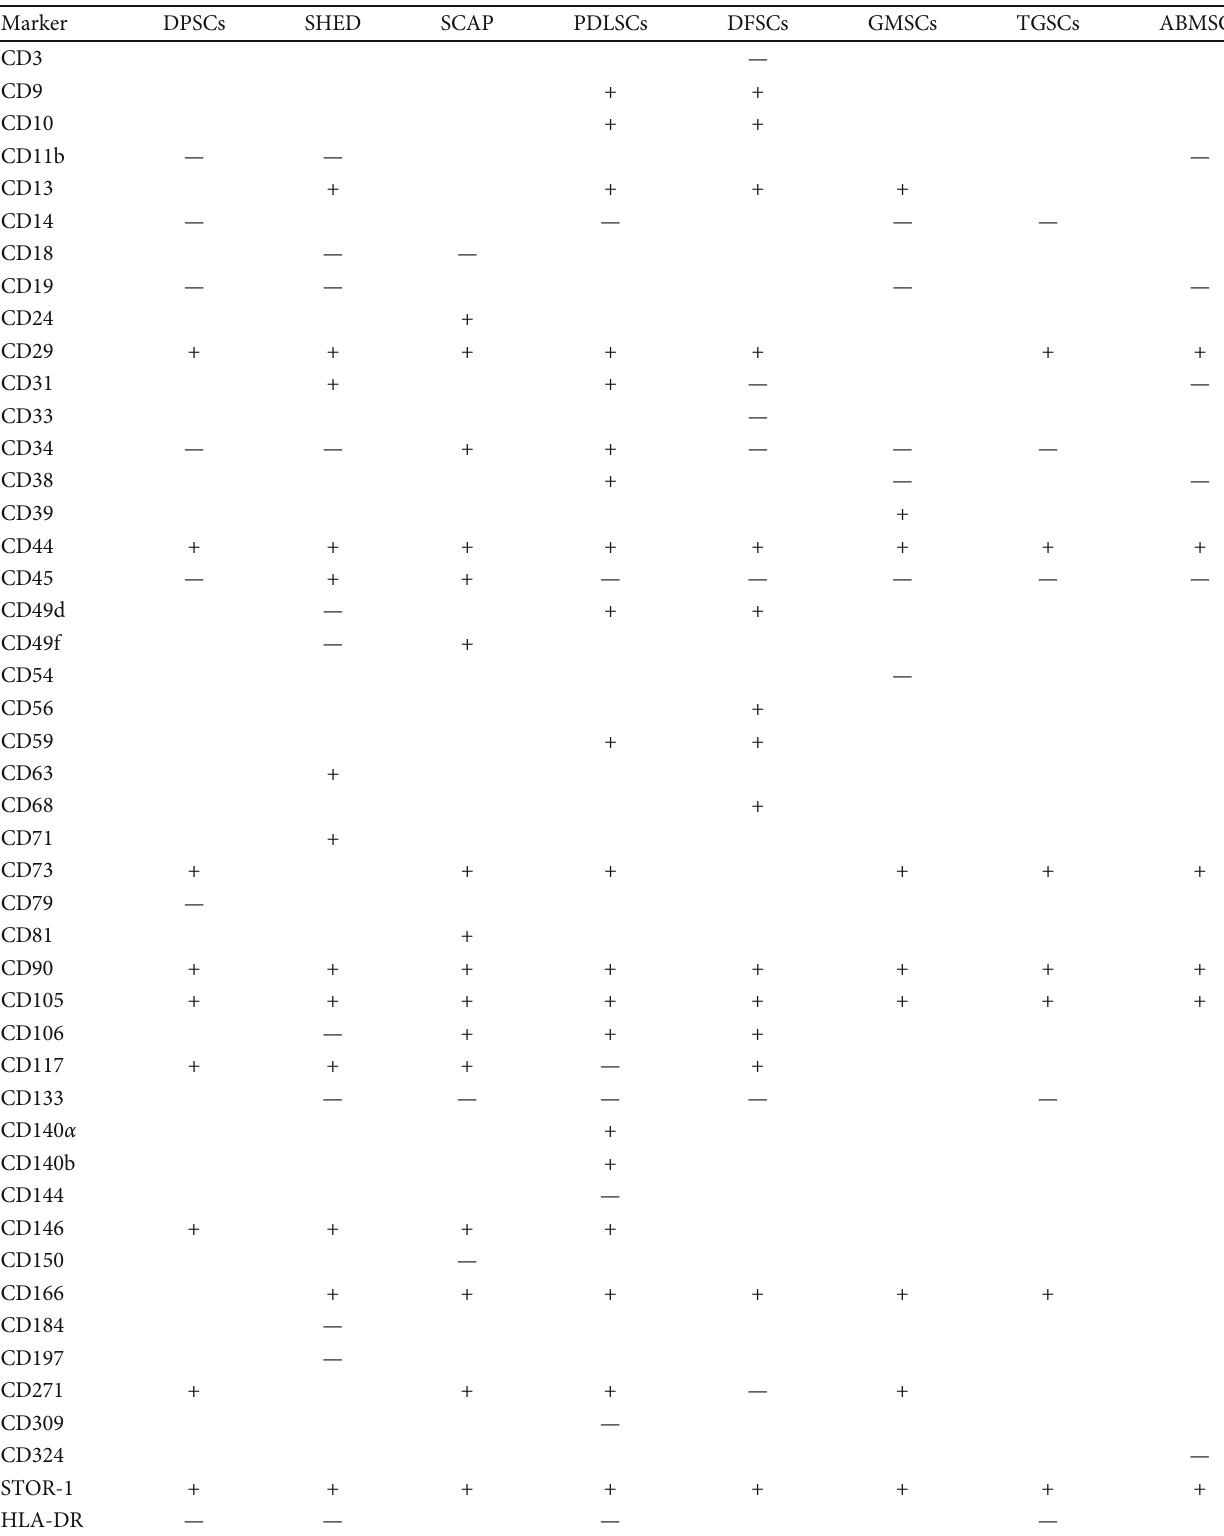
Table 1: Surface markers of human dental stem